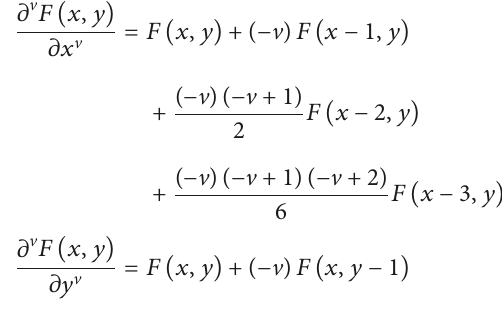
technique in recent years. By adjusting the fractional order of the Gaussian difference, an accurate and antinoise edge extraction effect can be obtained [16,